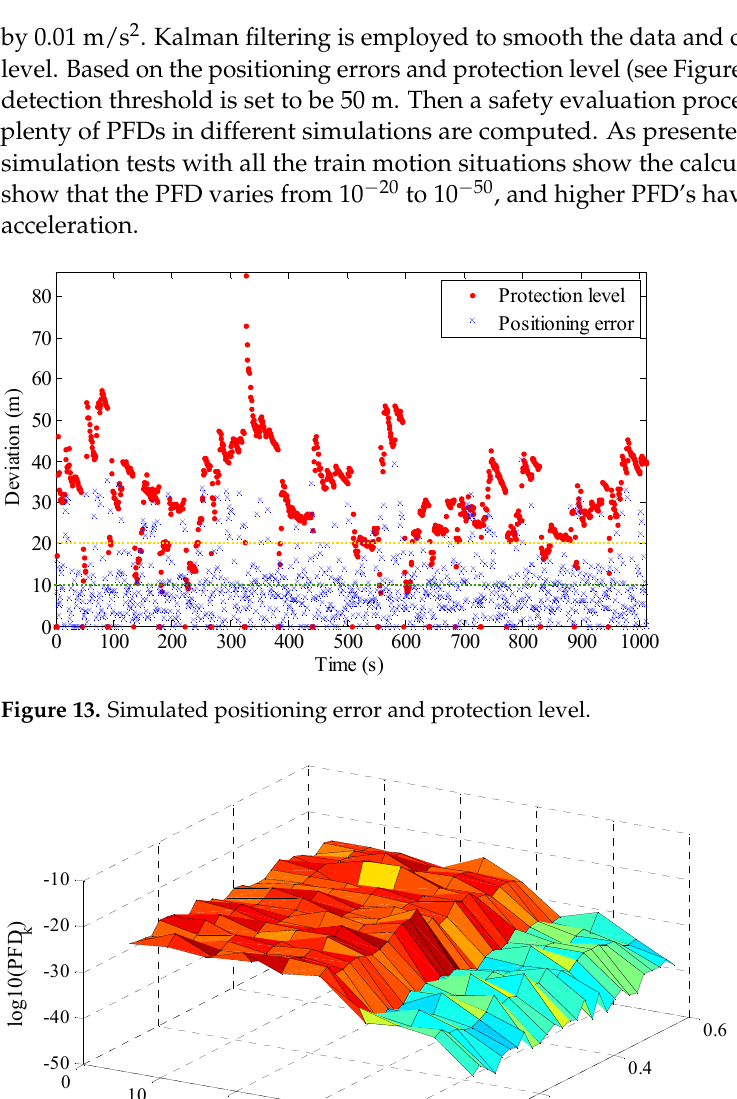
Figure 15. The PFH in 50 sets of simulation tests.